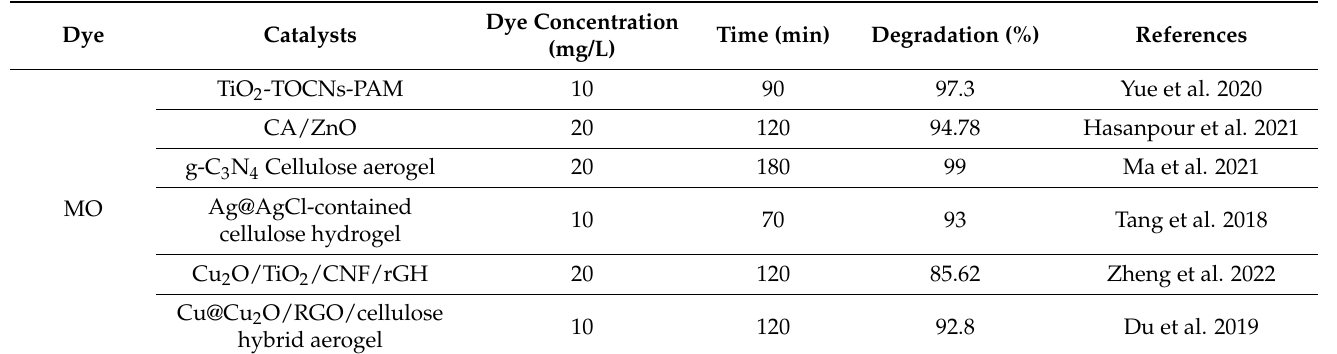
Table 3. Degradation efficiency of MO by different photocatalytic